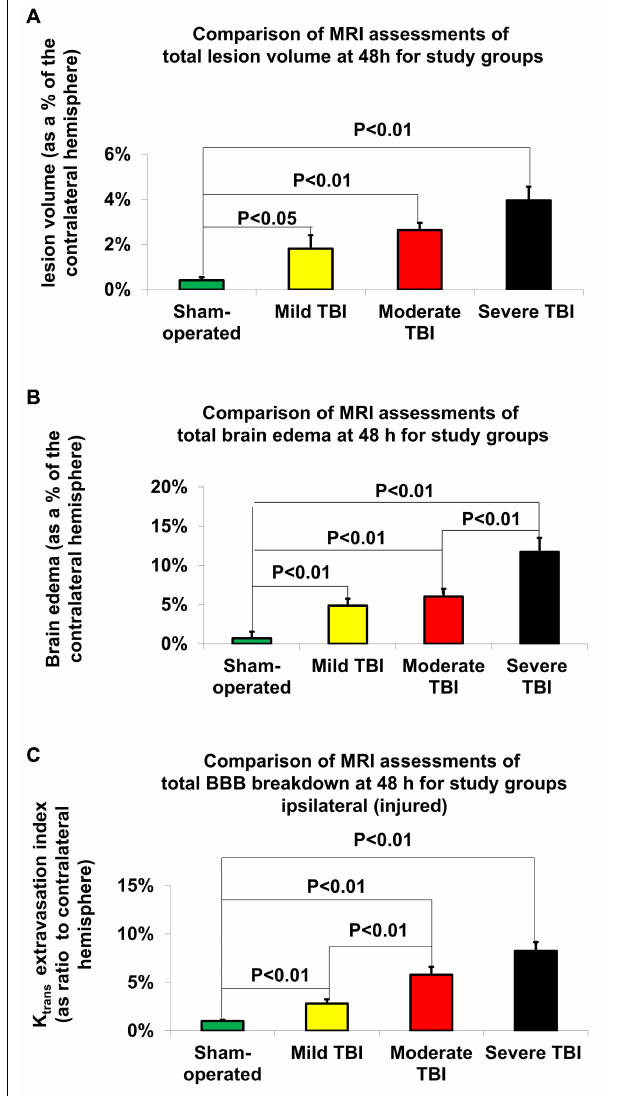
FIGURE 4 | MRI-determined outcome parameters 48 h after TBI. (A) Lesion volume. The data are expressed as a percentage of the contralateral hemisphere and presented as mean ± SEM. (B) Brain edema. The data are expressed as a percentage of the contralateral hemisphere and presented as mean ± SEM. (C) Blood-brain barrier (BBB) breakdown. The data are expressed as a percentage of the contralateral hemisphere and presented as mean ±